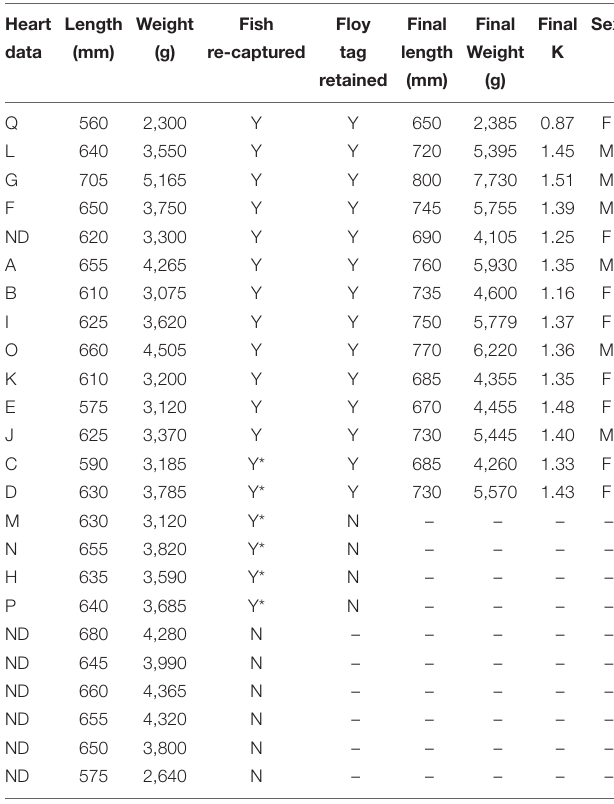
TABLE 1 | Summary of fish recapture rate and tag retention, fork length, weight, and condition factor K of tagged fish at tagging and